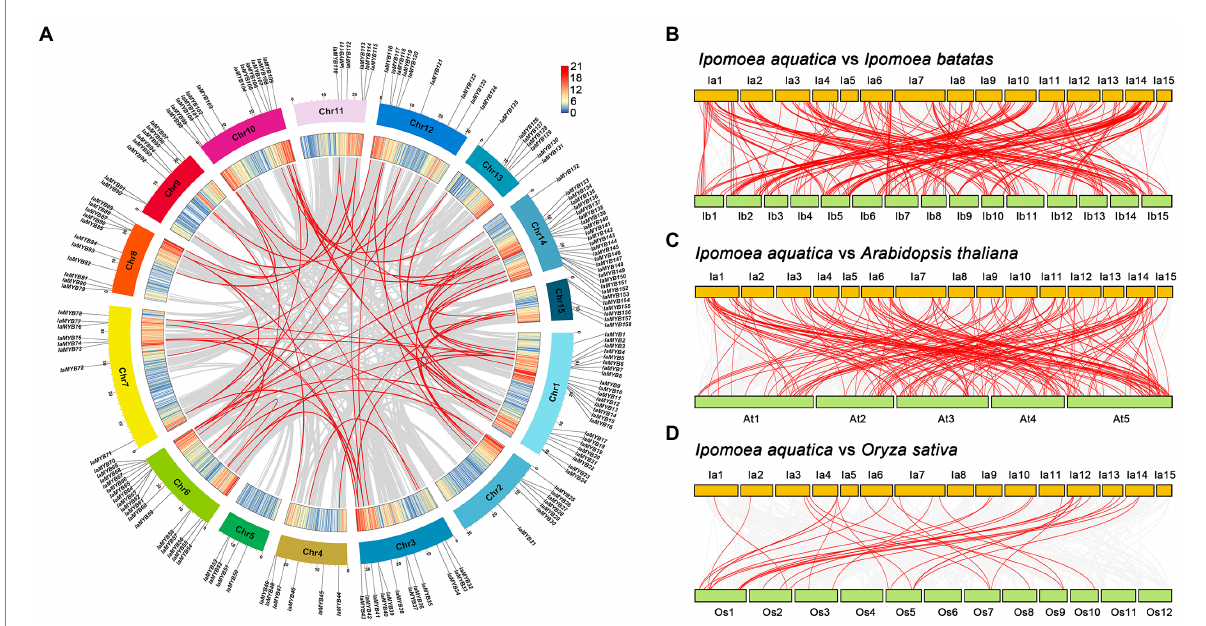
FIGURE 2 Analysis of IaMYB genes at the chromosome level. (A) Chromosome distribution of IaMYB genes and their collinear duplications in I. aquatica genome. The outer circle with different colors show 15 chromosomes of I. aquatica ; the inner circle shows the gene density of each chromosome. (B–D) Synteny analysis of IaMYB genes between I. batatas , A. thaliana , and O. sativa genomes, respectively. The gray line linked with each chromosome show all collinear gene pairs between I. aquatica and other plant genomes, while the red line show the collinear gene pairs with respect to IaMYB genes. Please refer to the Supplementary Table S3 for the detailed information of each gene